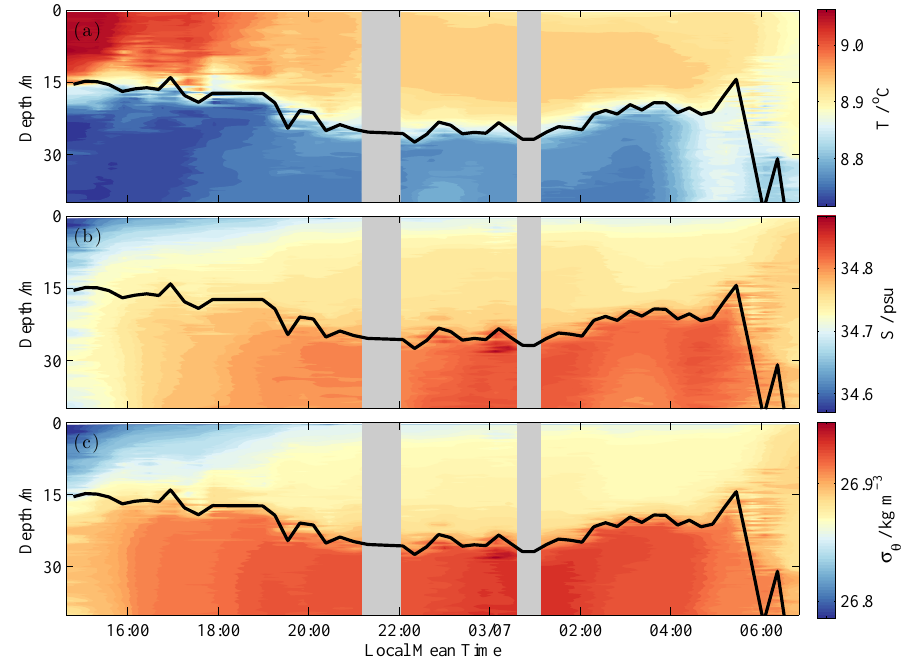
Fig. 8. (a) Temperature, (b) salinity, and (c) potential density as measured by the ASIP profiler. The solid black line denotes the mixed layer depth and the time has been corrected to local mean